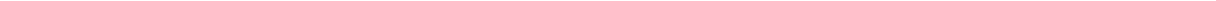
Fig. 4 Overview of the relative abundances of endogenous acyl-PTMs and intracellular metabolite concentrations. Bar plots showing the relative abundances of several lysine PTMs in a HeLa cells, b proliferative myogenic cells (myoblasts) and differentiated myogenic cells (myotubes). PTMs are shown as percentages representing the normalized relative abundances of all detectable peptides of canonical histones H3 and H4. c , d Bar plots showing the concentrations of acyl-CoA metabolites in c HeLa cells and d myogenic cells normalized to cell number. Metabolic concentrations of butyryl-CoA may also represent concentrations for isobutyryl-CoA. e – g Global histone acylation levels correlation with intracellular concentrations of acyl-CoA metabolic intermediates in e HeLa cells, f myoblasts and g myotubes. Correlations are calculated between the normalized net abundances of all detectable acylated peptides in H3 and H4 and the global concentrations CoA metabolites in pmol per cell. Insets show zoom in graphs with the linear correlation of the data without the values for acetyl-CoA and Kac. All results are shown as the average of three biological replicates and error bars represent the S.D. Summary of p -values is as follows; * p ≤ 0.05, ** p ≤ 0.01, and *** p ≤ 0.001. p -values were generated by unpaired Student ’ s t